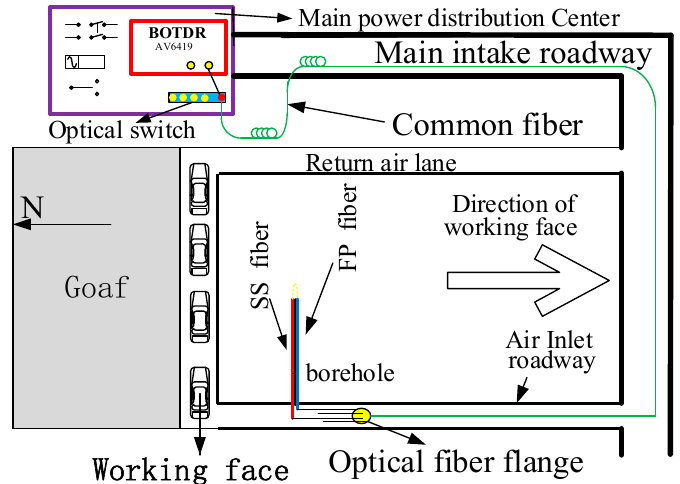
Figure 20. Roof strata movement monitoring system of BOTDR.